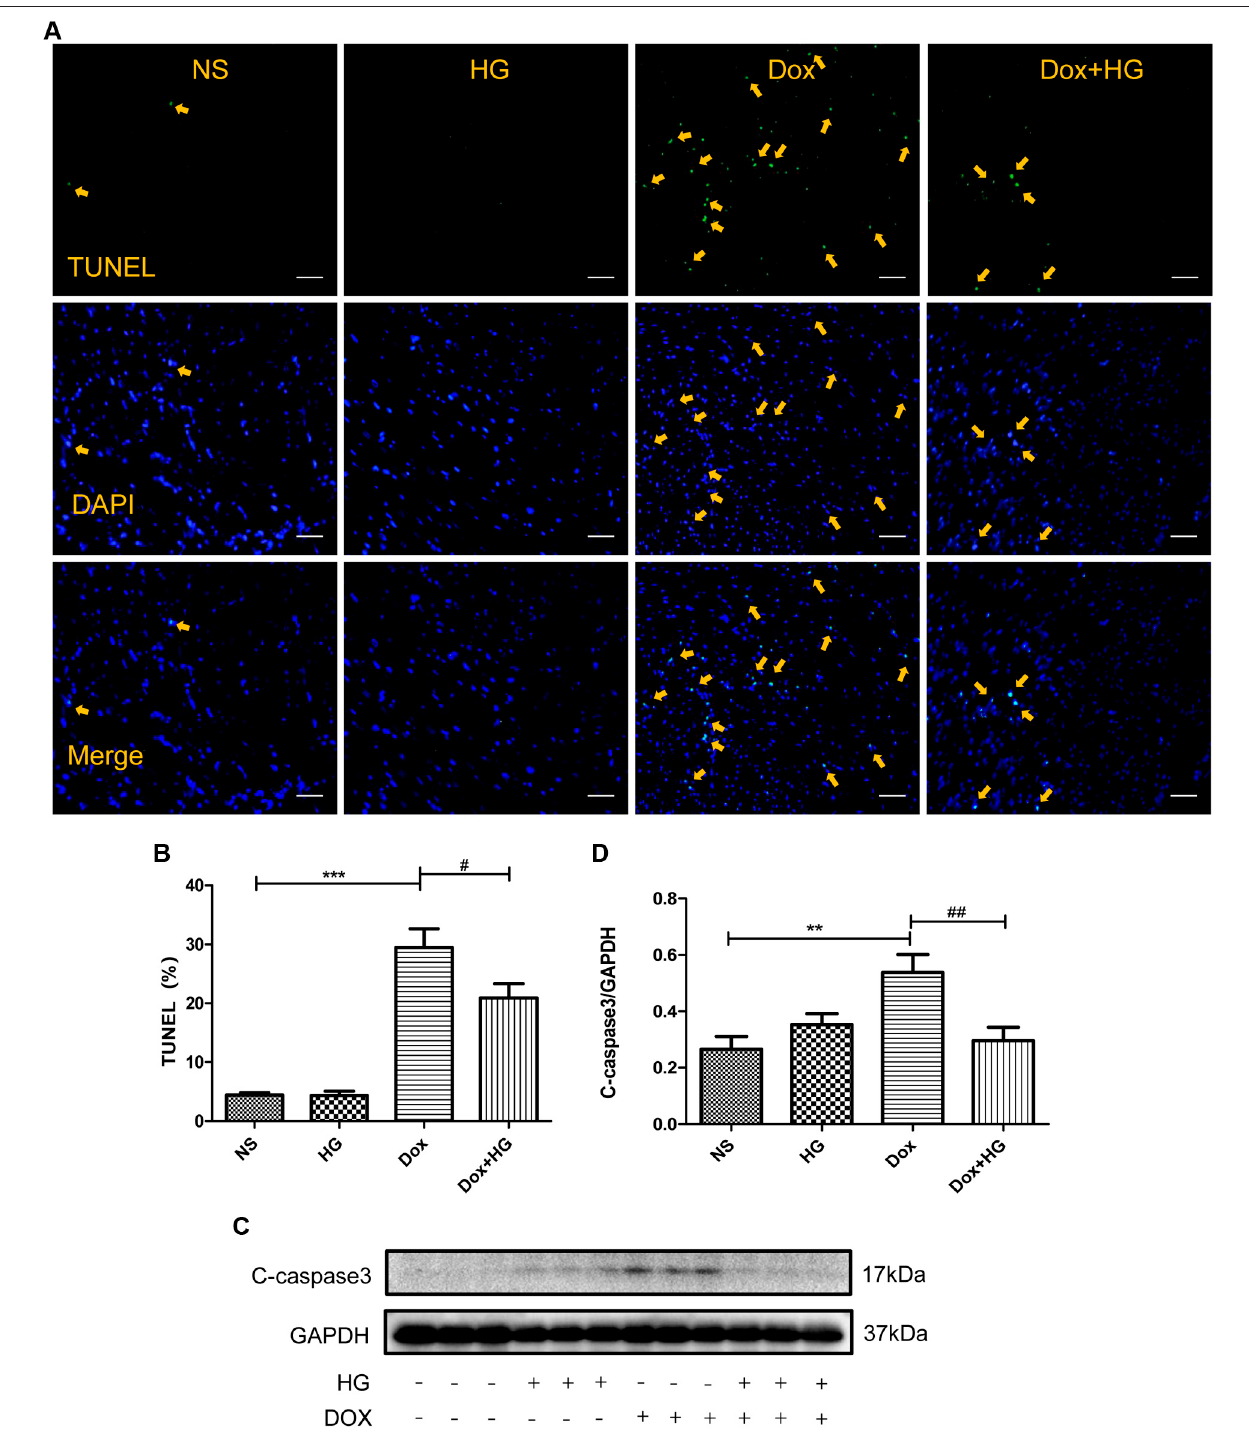
FIGURE 4 | HG inhibited DOX-induced cardiomyocyte apoptosis in vivo. (A) Representative TUNEL staining image of a myocardial section. Nuclei of apoptosis cellsaremarkedwithorangearrows. (B) QuantitativedataofnucleiofapoptosiscellsinmiceevaluatedbyTUNELstaining. (C) WesternblotanalysisofGAPDH,cleaved caspase 3 in cardiac tissues expressed in mice. (D) Quantitative data of cleaved caspase 3 expressed in mice. All values are presented as mean ± SEM; statistical analysiswasperformedusingPrism8.0one-wayANOVA.* p < 0.05DOXvsNS;# p < 0.05DOX+HGvsDOX.Animalnumbers:NS,n=8;HG,n=7;DOX,n=10; DOX + HG, n =